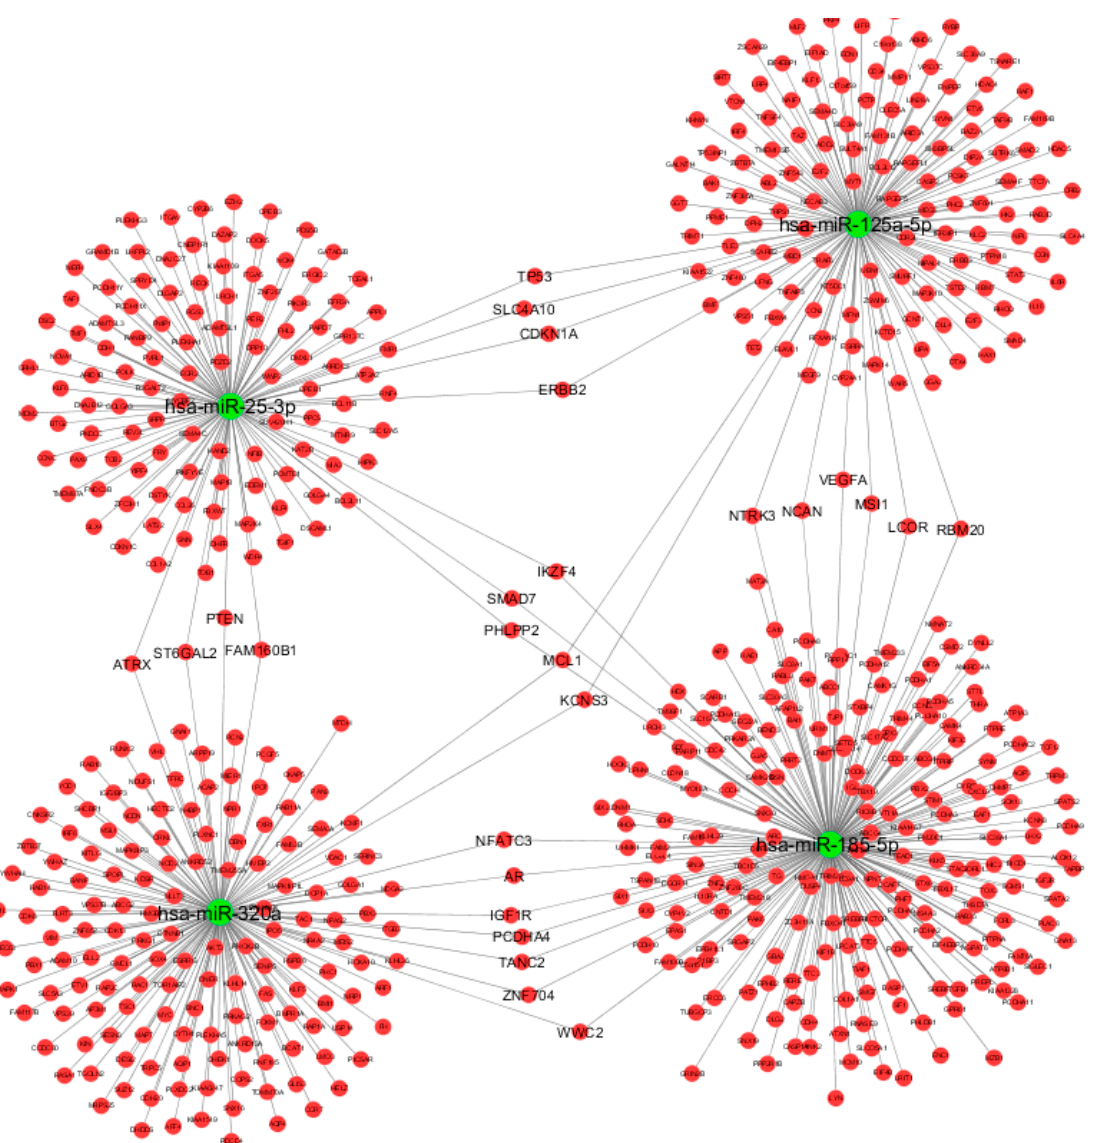
Figure 3. Graphical representation of computationally predicted/validated miRNA-target interactions using Cytoscape v3.6.0. Green nodes represent miRNAs, red nodes represent target genes. We excluded miR-942-5p and miR-652-3p miRNAs since our main purpose was to show the miRNA-based network.